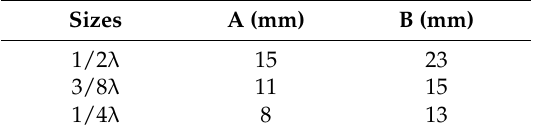
Figure 7. Temperature distributions of the high frequency snare at x = 0 mm.